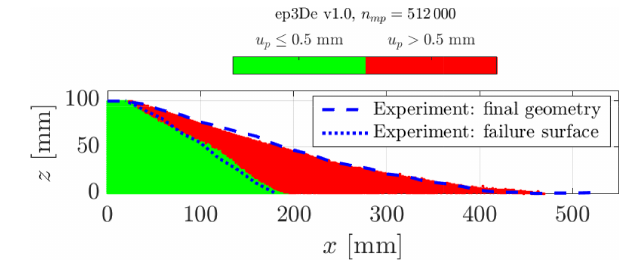
Figure 6. Final geometry of the granular collapse for three- dimensional configuration of our GPU-based explicit GIMPM im- plementation ep3De v1.0. The green region (i.e. the intact region) is defined by the L 2 norm of the material point displacement u p = || u p || ≤ 0.5mm, whereas the red region (i.e. the deformed region) 2 is defined by u p = || u p || 2 > 0.5mm. The experiment of Bui et al. (2008) is indicated by the blue dashed line (i.e. the free surface) and the blue dotted line (i.e. the failure